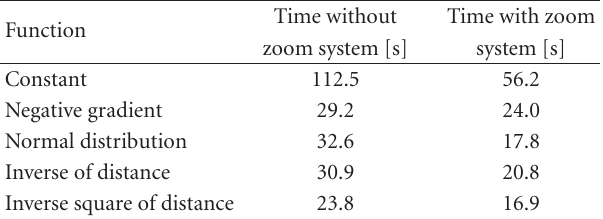
Table 1: Average time to locate 440 Hz sine wave.